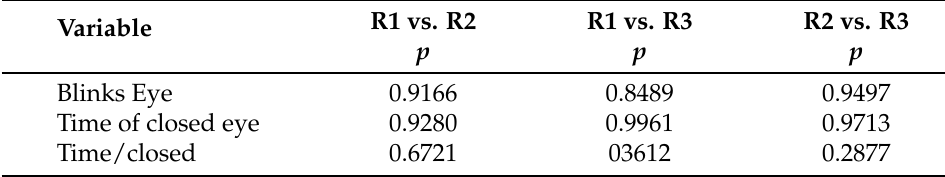
Table 4. Differences between analysis parameters in terms of heart rate